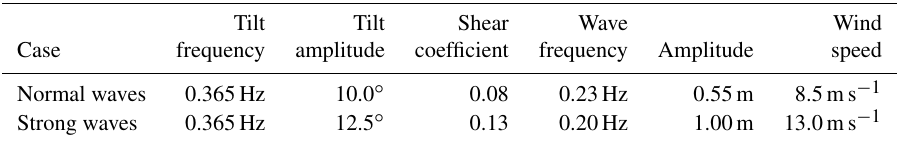
Table 2. Summary of test results from simulation of mean bias (MB) introduced by motion of FLS. Case Orientation MB rotation MB rotation&RBM MB translation MB total Normal waves Pitch/surge − 0 . 36% − 0 . 36% 0 . 07% − 0 . 24% Strong waves Pitch/surge − 0 . 76% − 0 . 76% 0 . 06% − 0 . 67% Normal waves Roll/sway − 0 . 07% 0 . 00% 0 . 25% 0 . 20% Strong waves Roll/sway − 0 . 17% − 0 . 12% 0 . 26% 0 .